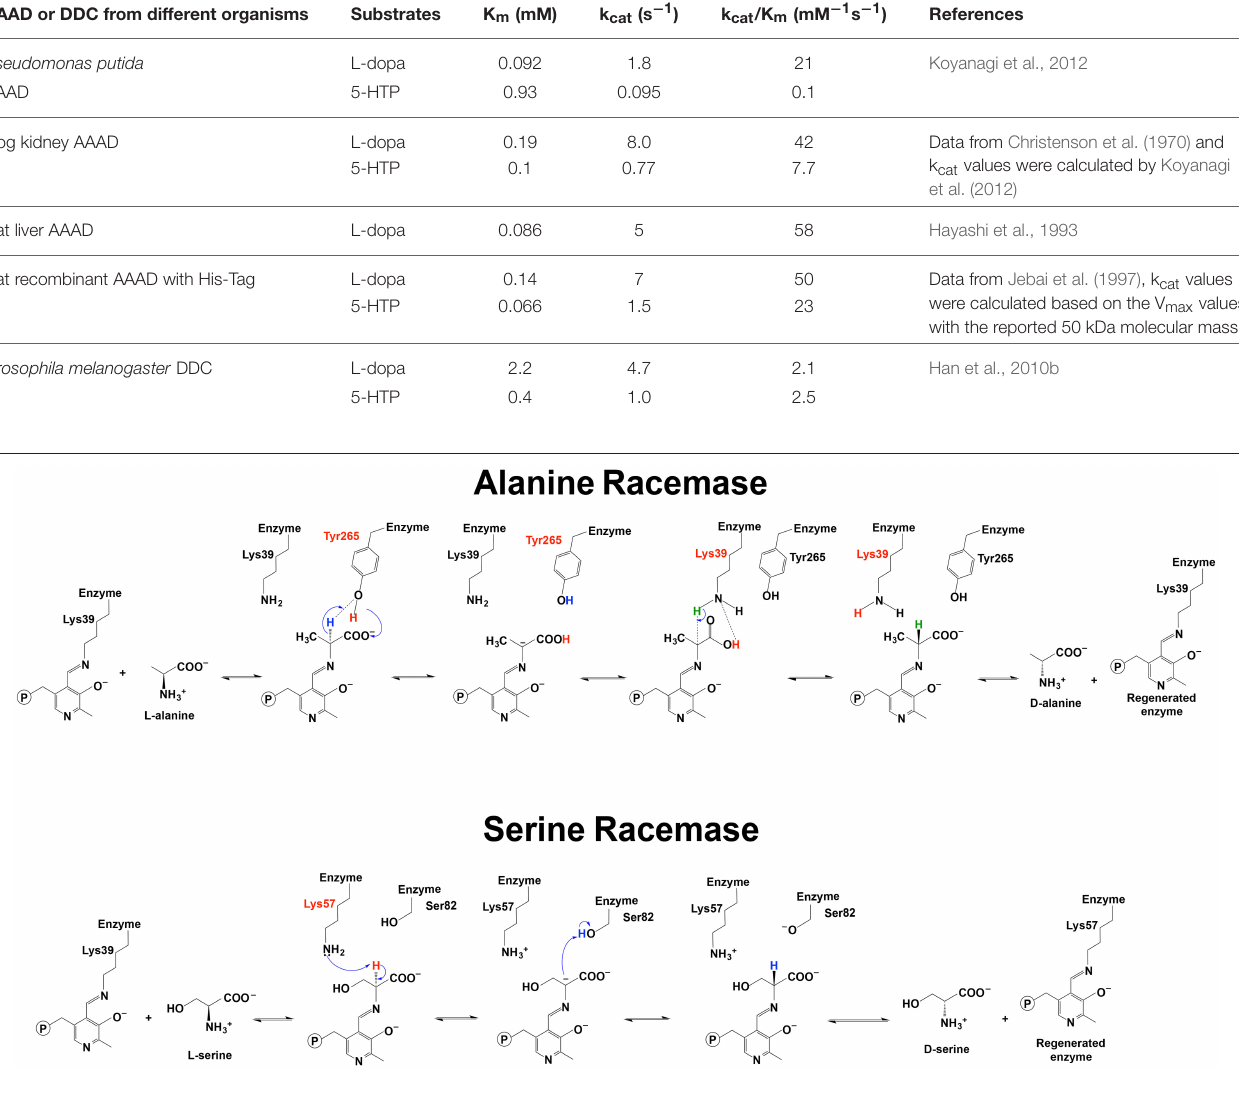
FIGURE 6 | Reaction mechanisms of alanine racemase and serine racemase (Watanabe et al., 1999, 2002; Yoshimura and Goto, 2008; Goto et al., 2009).